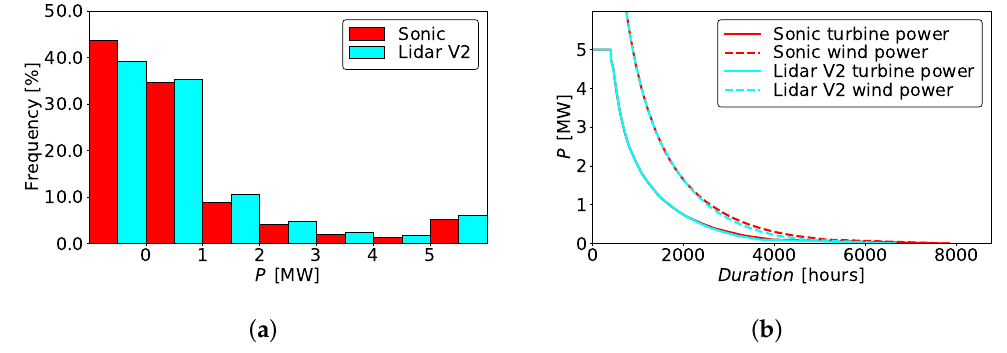
Figure 17. Power distribution of the site for the NREL 5-MW wind turbine. ( a ) Histogram of frequency of occurrence of power values estimated from the measured wind speed; ( b ) Wind turbine power duration